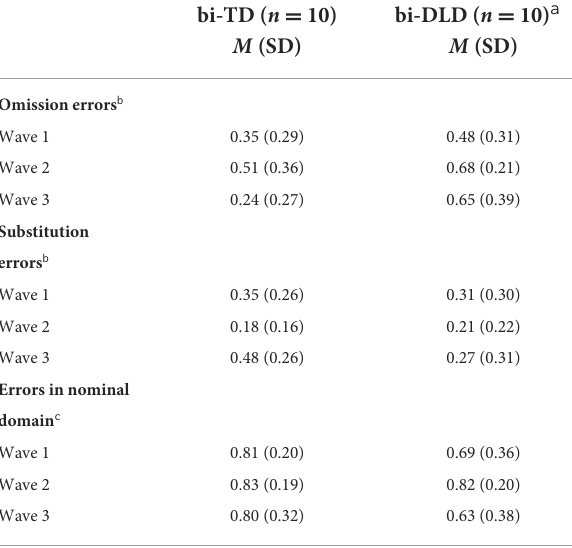
TABLE 4 Proportions of grammatical morpheme errors per type and domain in